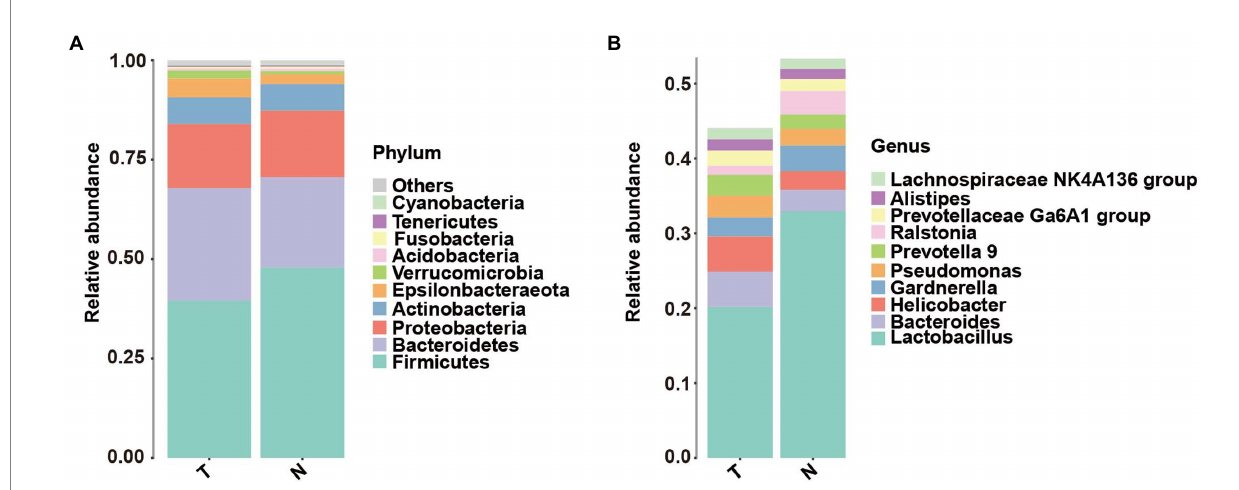
FIGURE 2 Abundance of microbes at different levels in the embryo-arrest and normal pregnancy groups. (A) Relative abundances of the vaginal microbiota at the phylum level. (B) Relative abundances of the vaginal microbiota at the genus level. T, embryo-arrest group; N, normal pregnancy